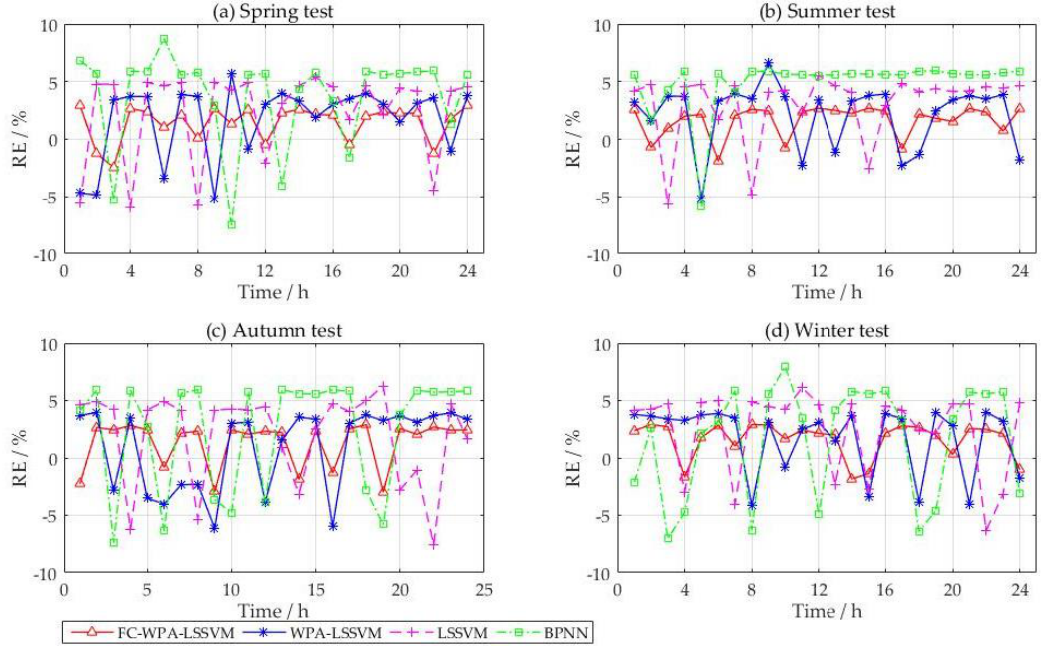
Figure 10. RE of forecasting approaches: ( a ) RE of Spring test; ( b ) RE of Summer test; ( c ) RE of Autumn test; ( d ) RE of Winter test.